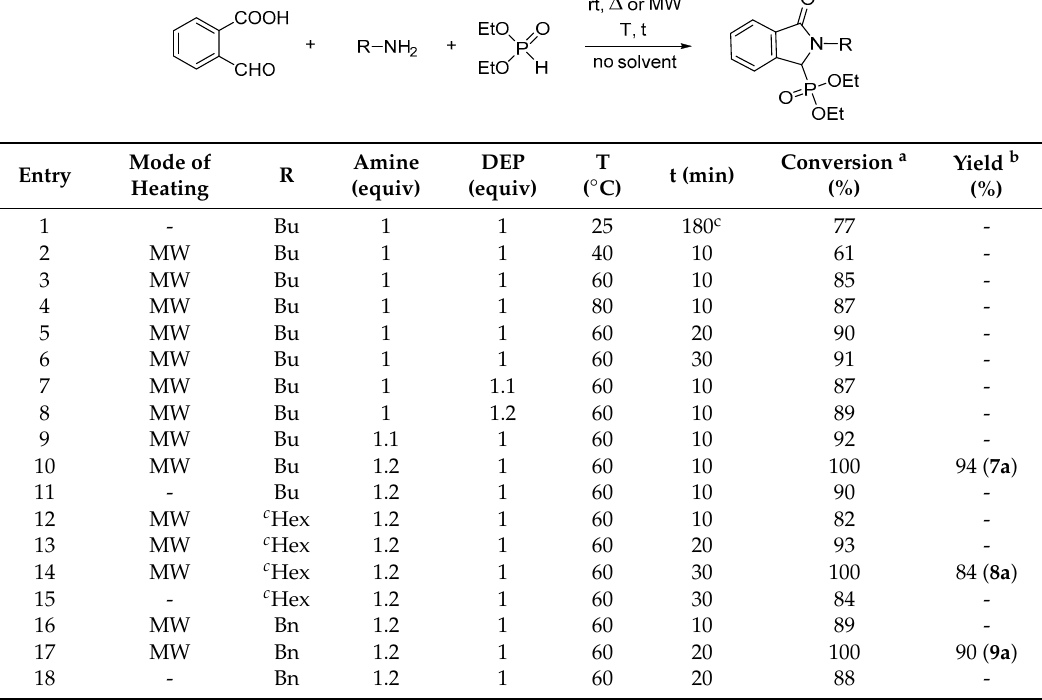
Table 1. Optimization of the condensation of 2-formylbenzoic acid, aliphatic primary amines and diethyl phosphite in a batch microwave reactor.